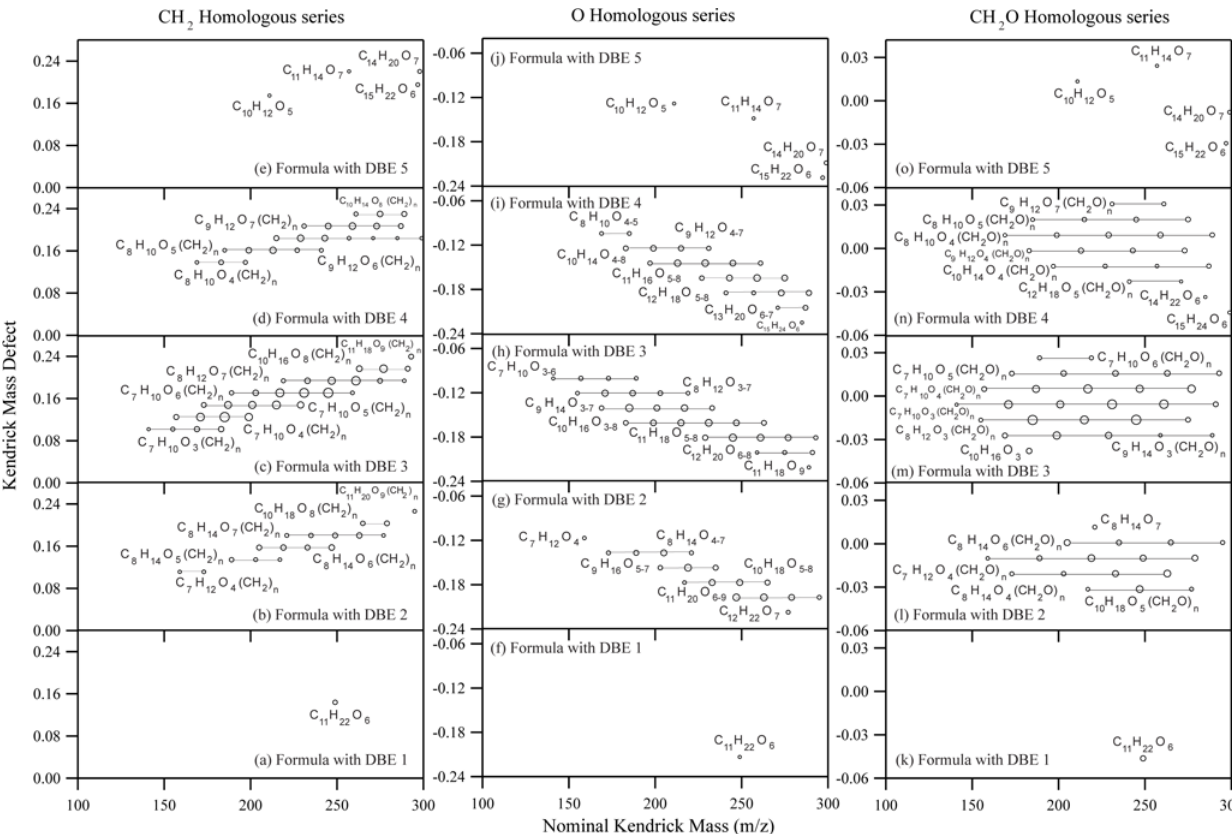
Fig. 1. CH 2 , O and CH 2 O homologous series of negative ions with ≥ 1% relative abundance for the mass range of 140 < m/z < 300. Com- ponents of the homologous series fall onto the horizontal lines. Data points were scaled according to the logarithm of their measured relative abundances. The value of “ n ” starts from zero. Table 1. Chemical characteristics of the groups of compounds observed in the mass spectra. Compounds O:C H:C DBE OM:OC